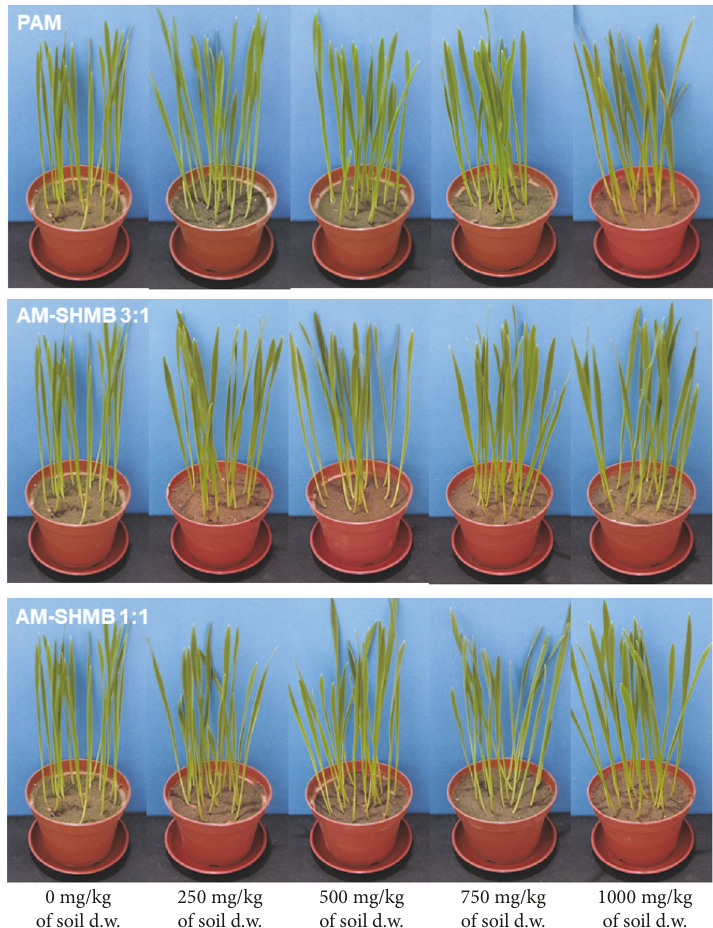
Figure 5: Digital photographs of oat seedlings growing for 14 days in soil treated with PAM and Tulipalin A-based